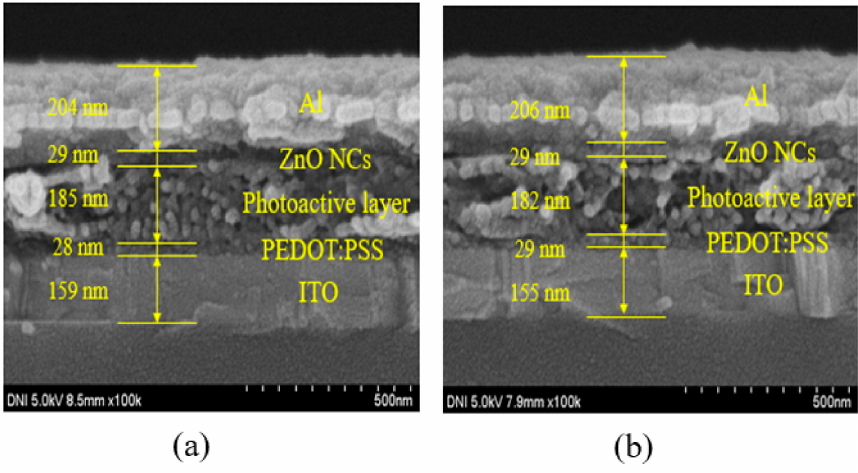
Figure 4. FE-SEM cross-sectional images of ( a ) BHJ-PSCs fabricated with bare ZnO NPs ( b ) and BHJ-PSCs fabricated with PVP-capped ZnO